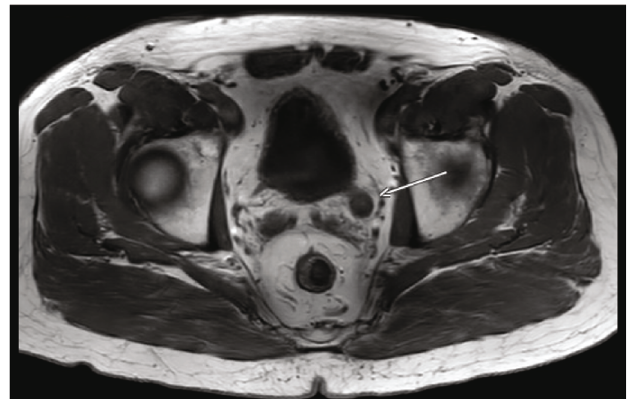
Figure 3: MRI with left distal ureteral recurrence